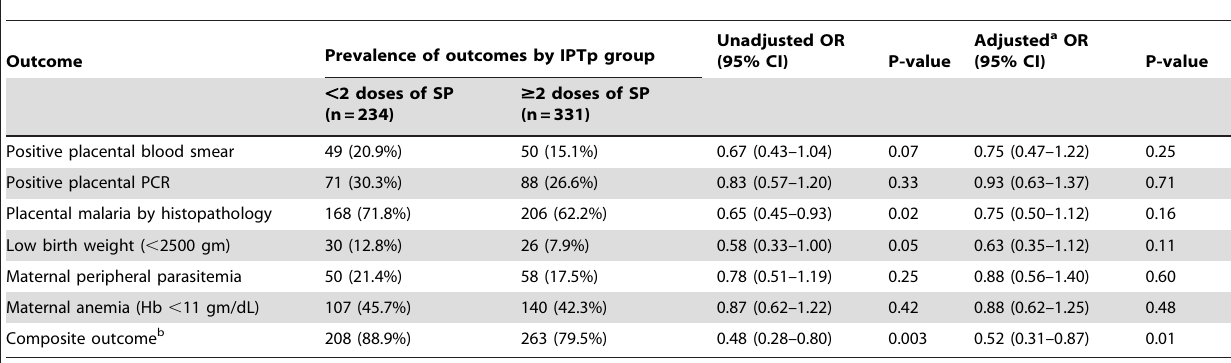
Table 2. Associations between use of IPTp-SP and outcomes at delivery.